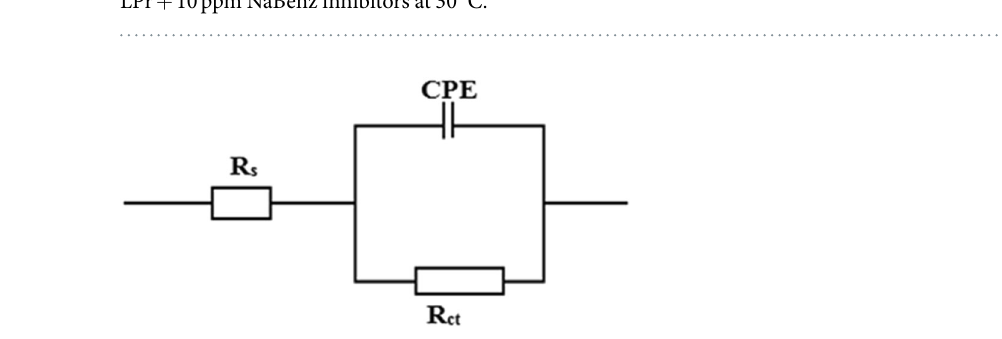
Figure 6. Equivalent circuit model used to fit the impedance measurement data for MS in 1M HCl ( R s = solution resistance, R ct = charge-transfer resistance, and CPE = constant phase